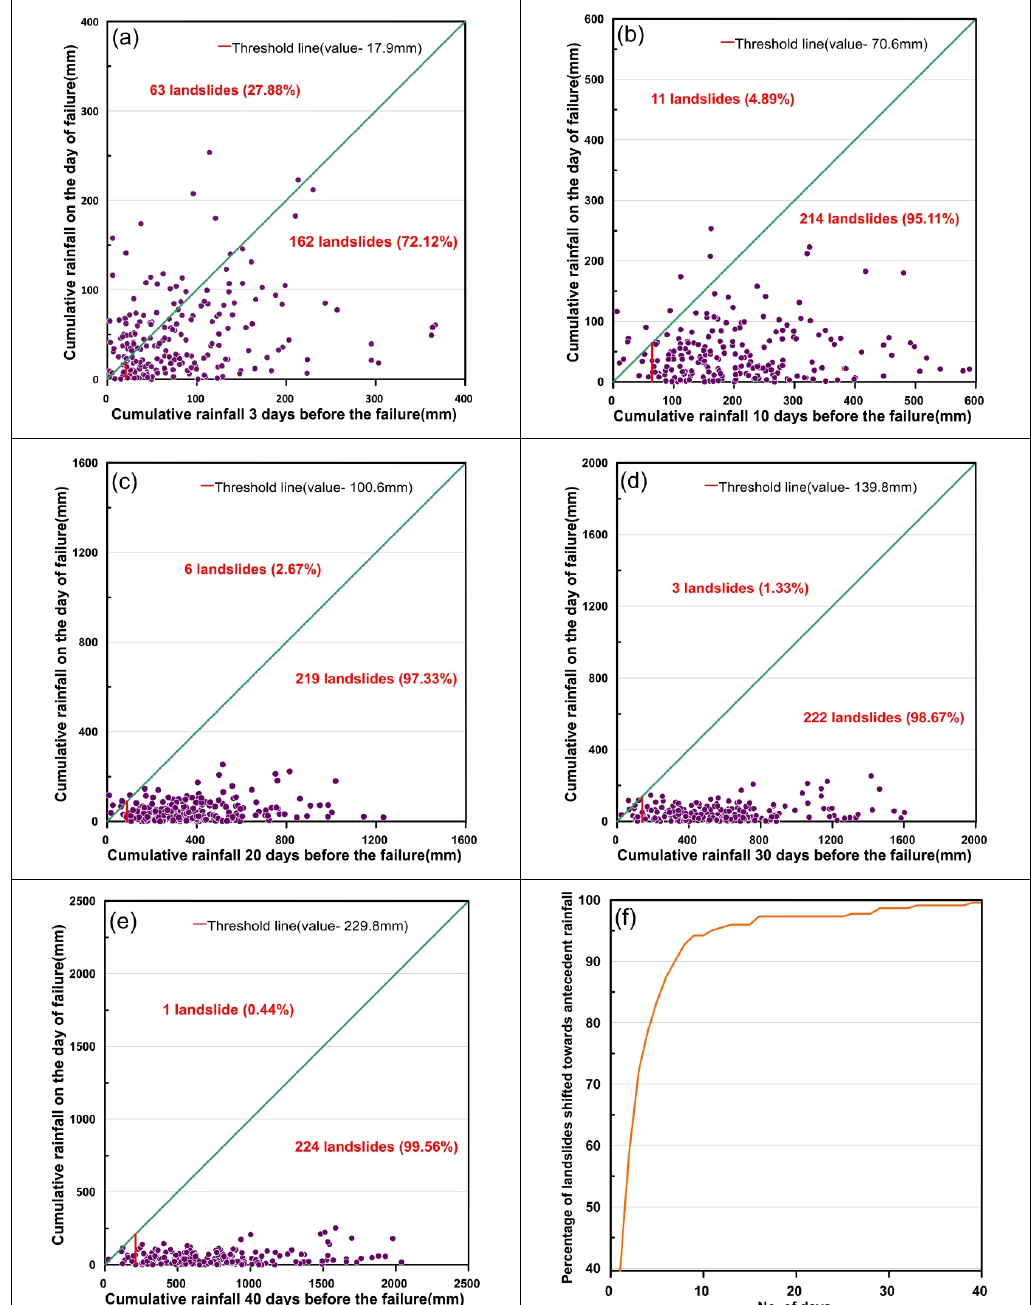
Figure 11. Plot between daily rainfall and antecedent rainfall before failure for ( a ) 3 days, ( b ) 10 days, ( c ) 20 days, ( d ) 30 days, ( e ) 40 days, and ( f ) Biasness towards antecedent rainfall.